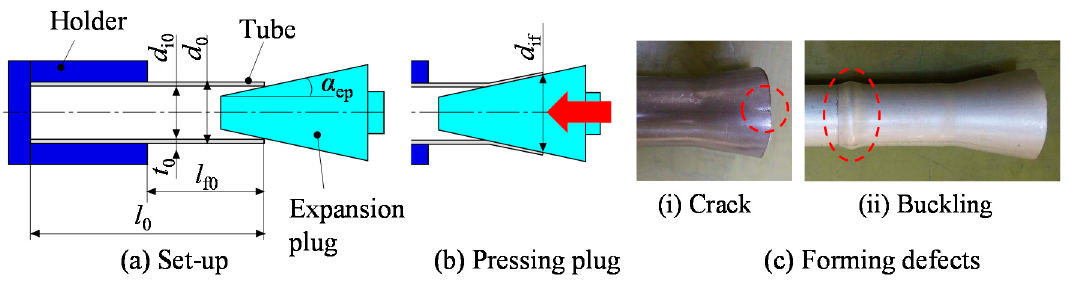
Figure 3. Schematic diagram of flaring experiment.